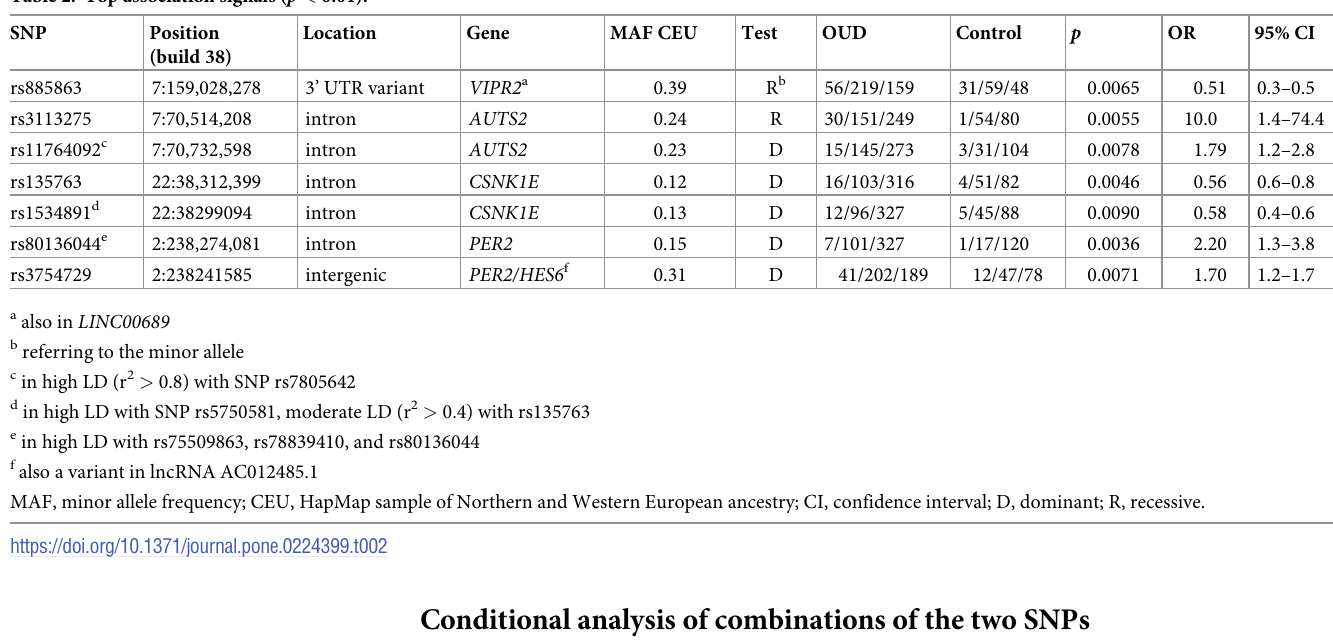
Conditional analysis of genotype combinations of the two SNPs revealed an association of